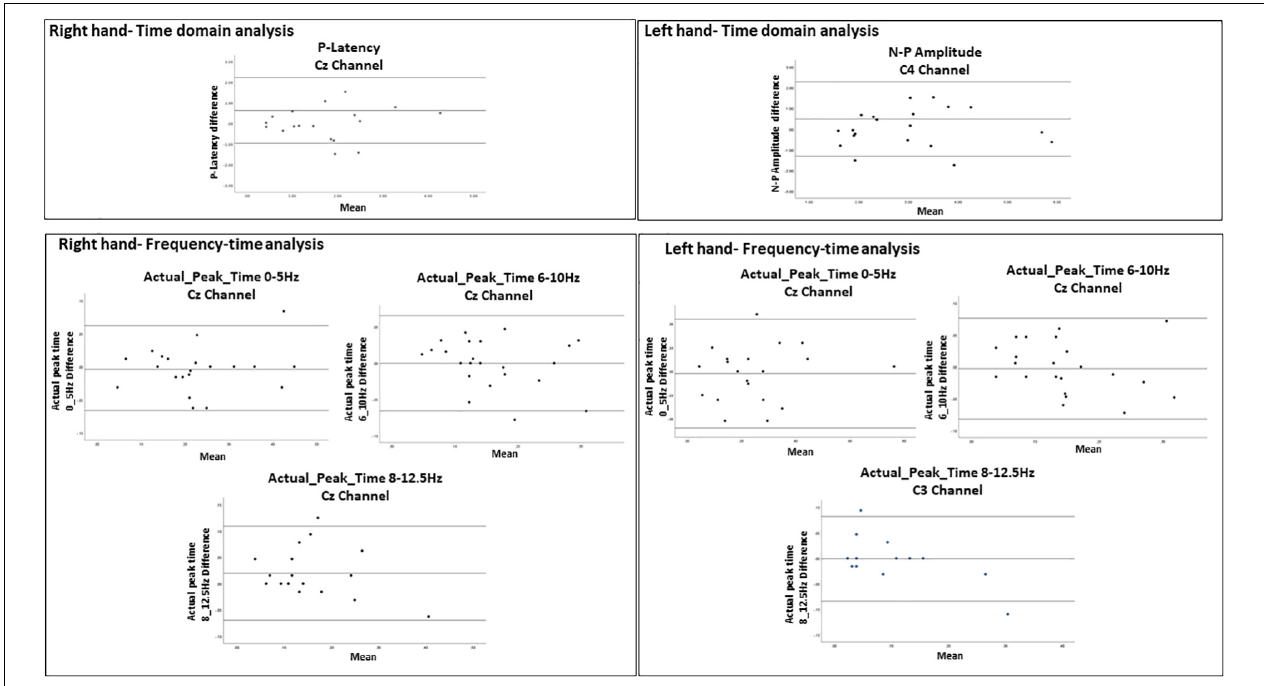
FIGURE 6 | Bland-Altman plots demonstrating the 95% limits of agreement between 1st and 2nd sessions for variables with ICC = 0.75. The middle line represents the mean. The upper and lower line represent the upper and lower limits of agreement (mean ± 1.96 SD ), respectively. The Bland-Altman analysis could not be performed for actual_peak_time analysis 0_5 Hz for C3 channel because the difference was found significant ( p =